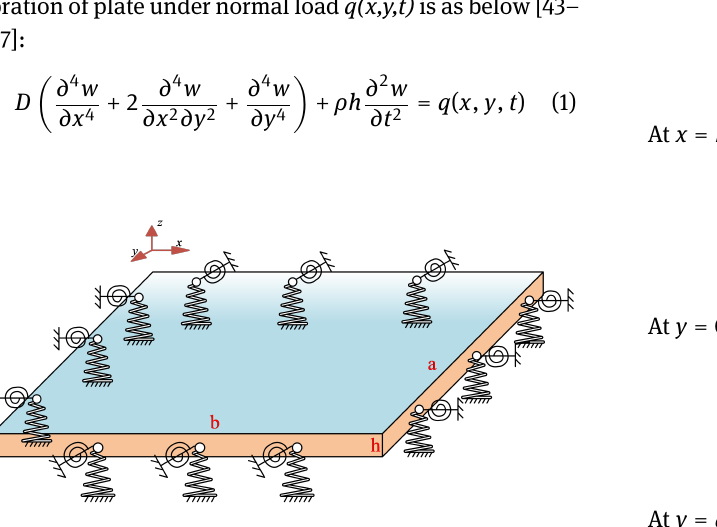
Figure 1: Rectangular thin plate with general boundary condition